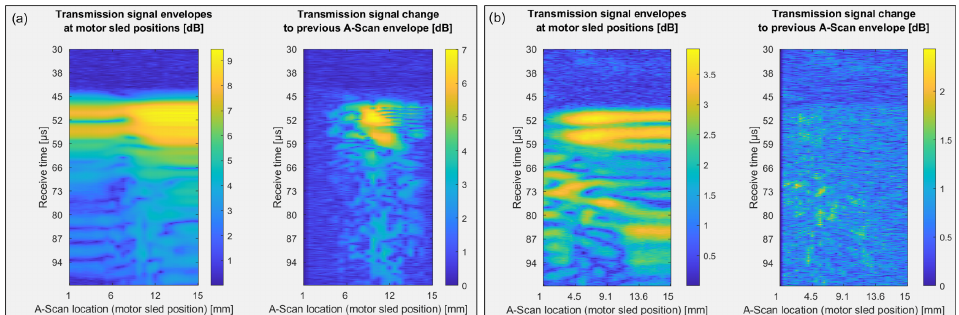
Figure 9. Analysis of measurement data plotted as A ‐ scans (color coded) over motor movement (x ‐ axis) and measurement time (y ‐ axis) of a person with an open growth plate ( a ) and an ossified growth plate ( b ); transmission signal envelope amplitude (left ‐ hand plot in panels a and b ) and transmission signal change (difference signal change to previous A ‐ Scan, right ‐ hand plot in panels a and b ).